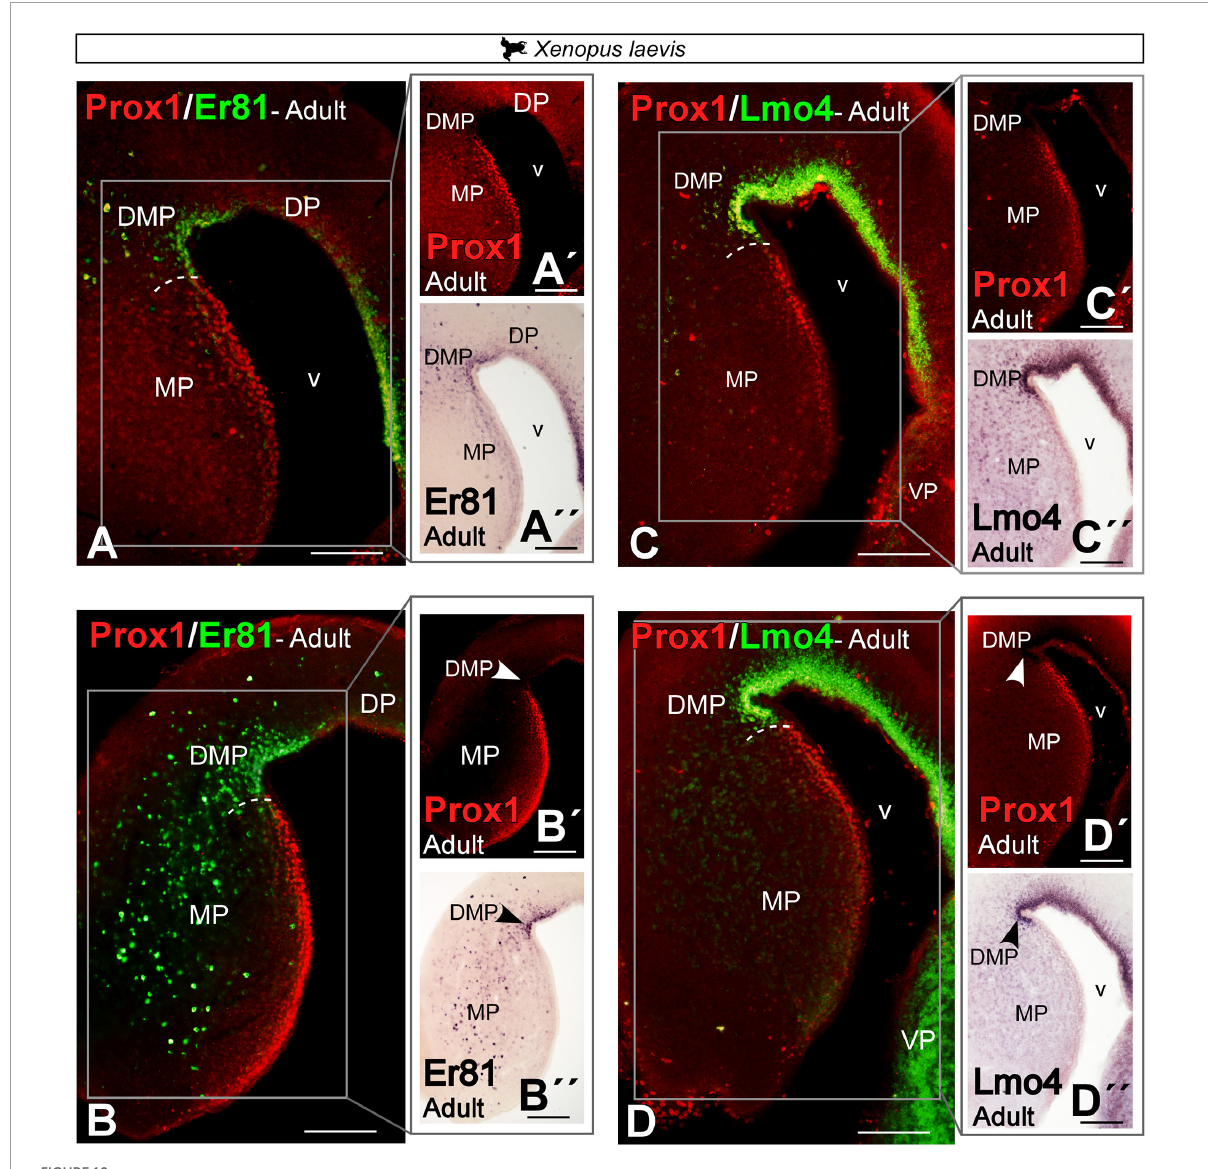
FIGURE10 Photomicrographs of transverse sections through the telencephalon of Xenopus laevis (A–D) showing, from rostral to caudal levels, the Prox1/Er81 (A,B) and the Prox1/Lmo4 expressions (C,D) . The white box in the figures (A–D) corresponds to the magnifications shown in the adjacent photos with the single staining (A (cid:48) –D (cid:48) ,A (cid:48)(cid:48) –D (cid:48)(cid:48) ) . In each panel, the color code for the used markers is indicated. Scale bar = 200 µ m. See the abbreviation list.